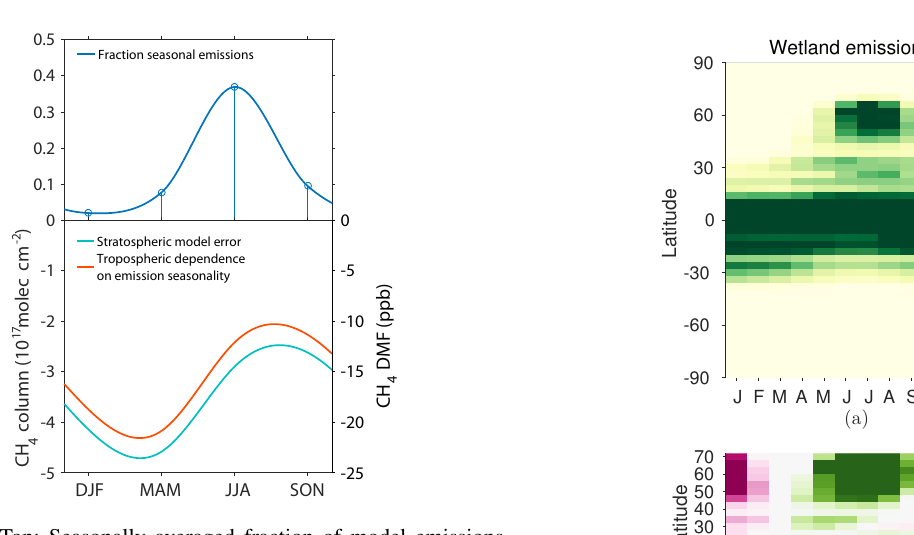
Figure 9. Top: Seasonally averaged fraction of model emissions from seasonally varying sources, north of 40 ◦ N. Bottom: Season- ally averaged normalized model stratospheric column error (teal) and the difference between base and aseasonal simulation tropo- spheric columns (orange) at Park Falls.